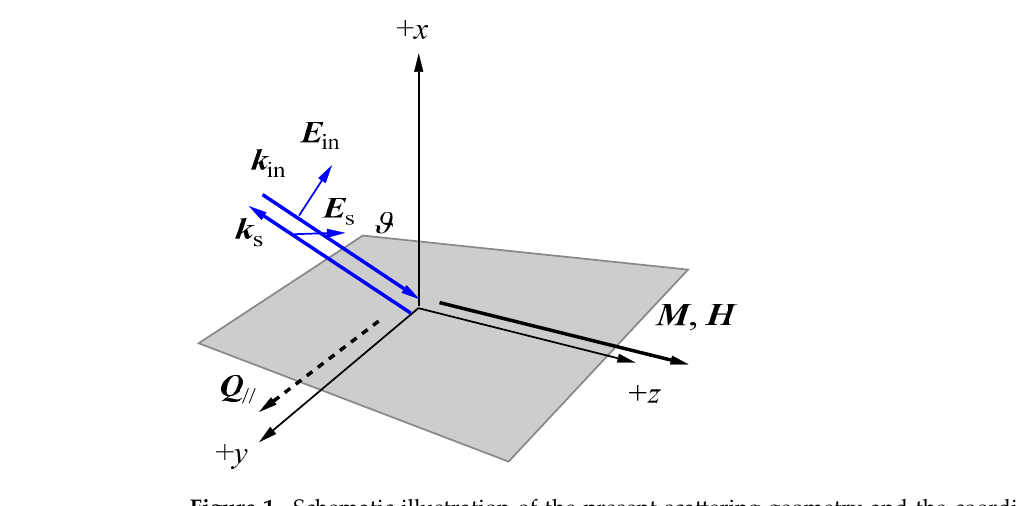
Figure 1. Schematic illustration of the present scattering geometry and the coordinate system for BLS spectrum calculation. The s -polarized component of the scattered beam is selected by using a polarizing beam splitter placed in front of the tandem FPI.